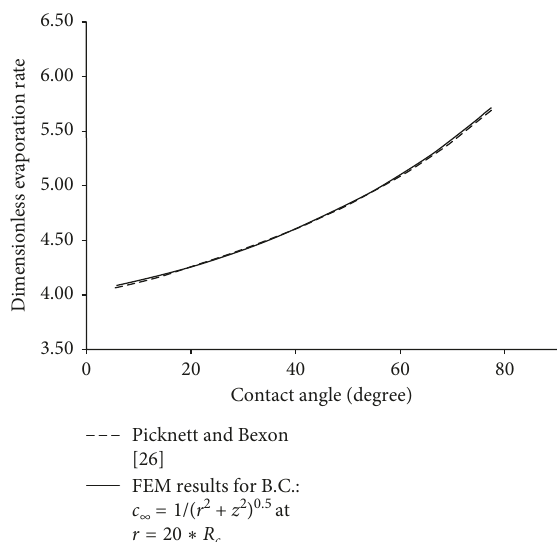
Figure 1: Comparison of the total evaporation rate between our FEM results and Picknett and Bexon’s results. Initial aspect ratio (AR) � 0.8.